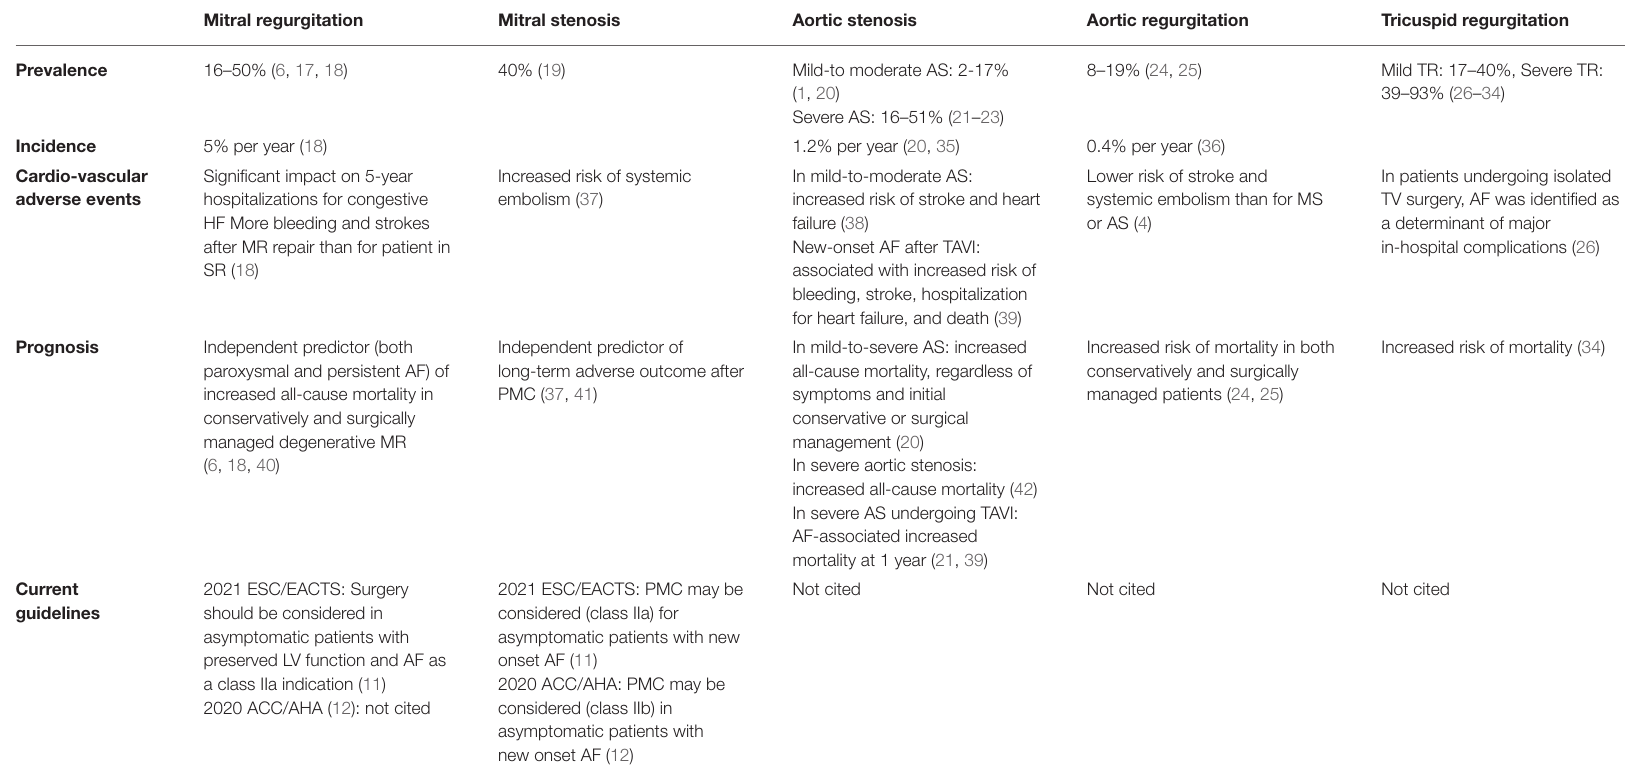
TABLE 1 | Atrial fibrillation in common sub-types of valvular heart disease: prevalence, impact on outcomes, and considerations related to the association of atrial fibrillation with valvular heart disease in current guidelines. Mitral regurgitation Mitral stenosis Aortic stenosis Aortic regurgitation Tricuspid